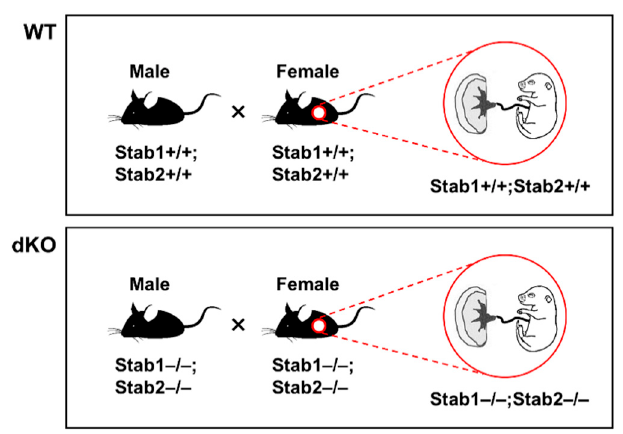
Figure 2. Pedigree and genotypes for obtaining embryos and placentas from pregnant females for the experiments.